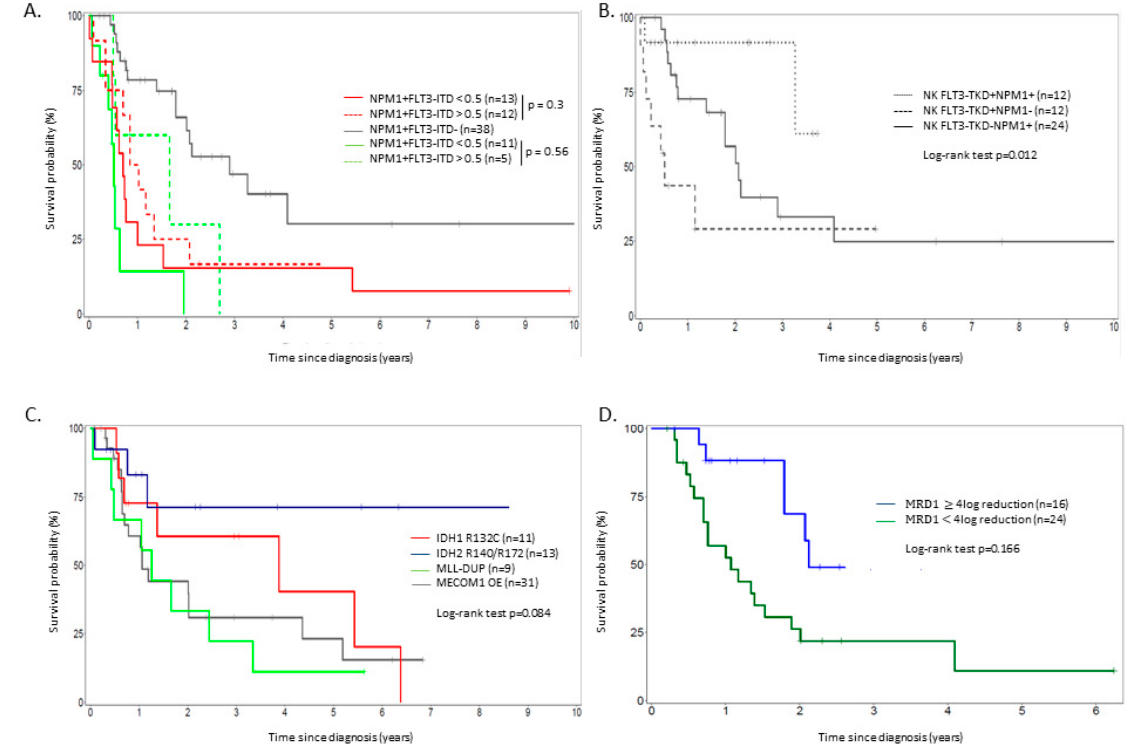
Figure 2. ( A ) Overall survival in NK patients according to their NPM1 / FLT3-ITD status, ( B ) overall survival in FLT3-ITD − patients according to NPM1 and FLT3-TKD status, ( C ) overall survival in patients with IDH1 R132, IDH2 R140Q / R172K, MLL-DUP mutations and MECOM1 overexpression, independently of the karyotype, ( D ) overall survival in NPM1 mutated patients according to NPM1 MRD1 log reduction (all patients were treated intensively).